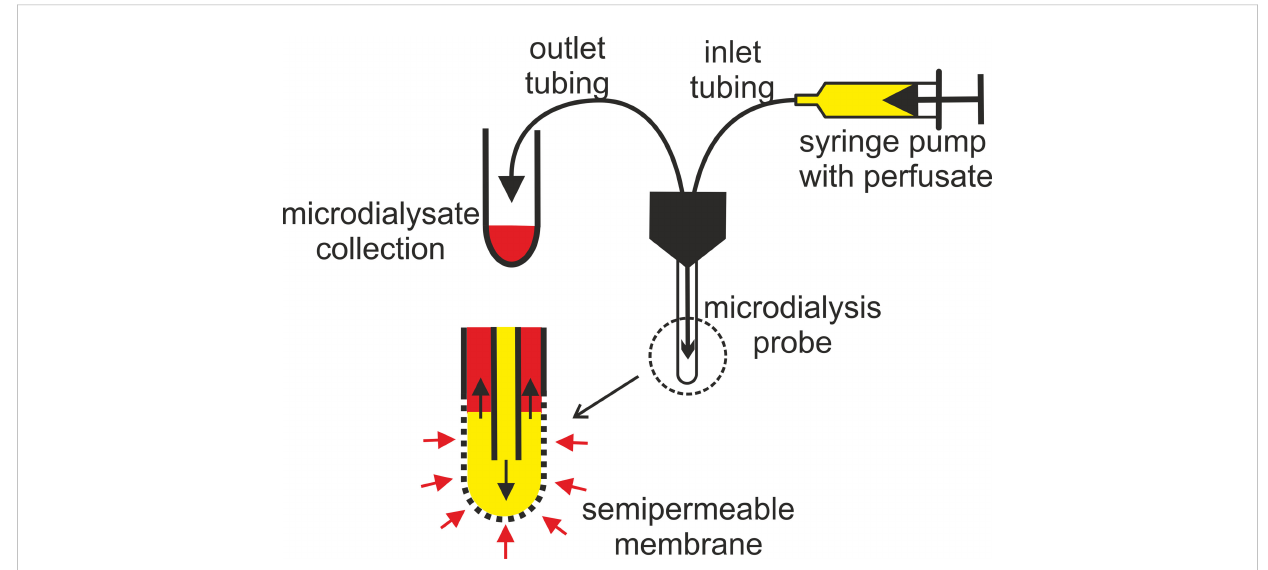
FIGURE 1 Principle of microdialysis tissue sampling showing a probe tip equipped with a selective membrane. Black arrows indicate the direction of perfusate fl ow; red arrows indicate the direction of metabolite diffusion; perfusate (yellow), microdialysate